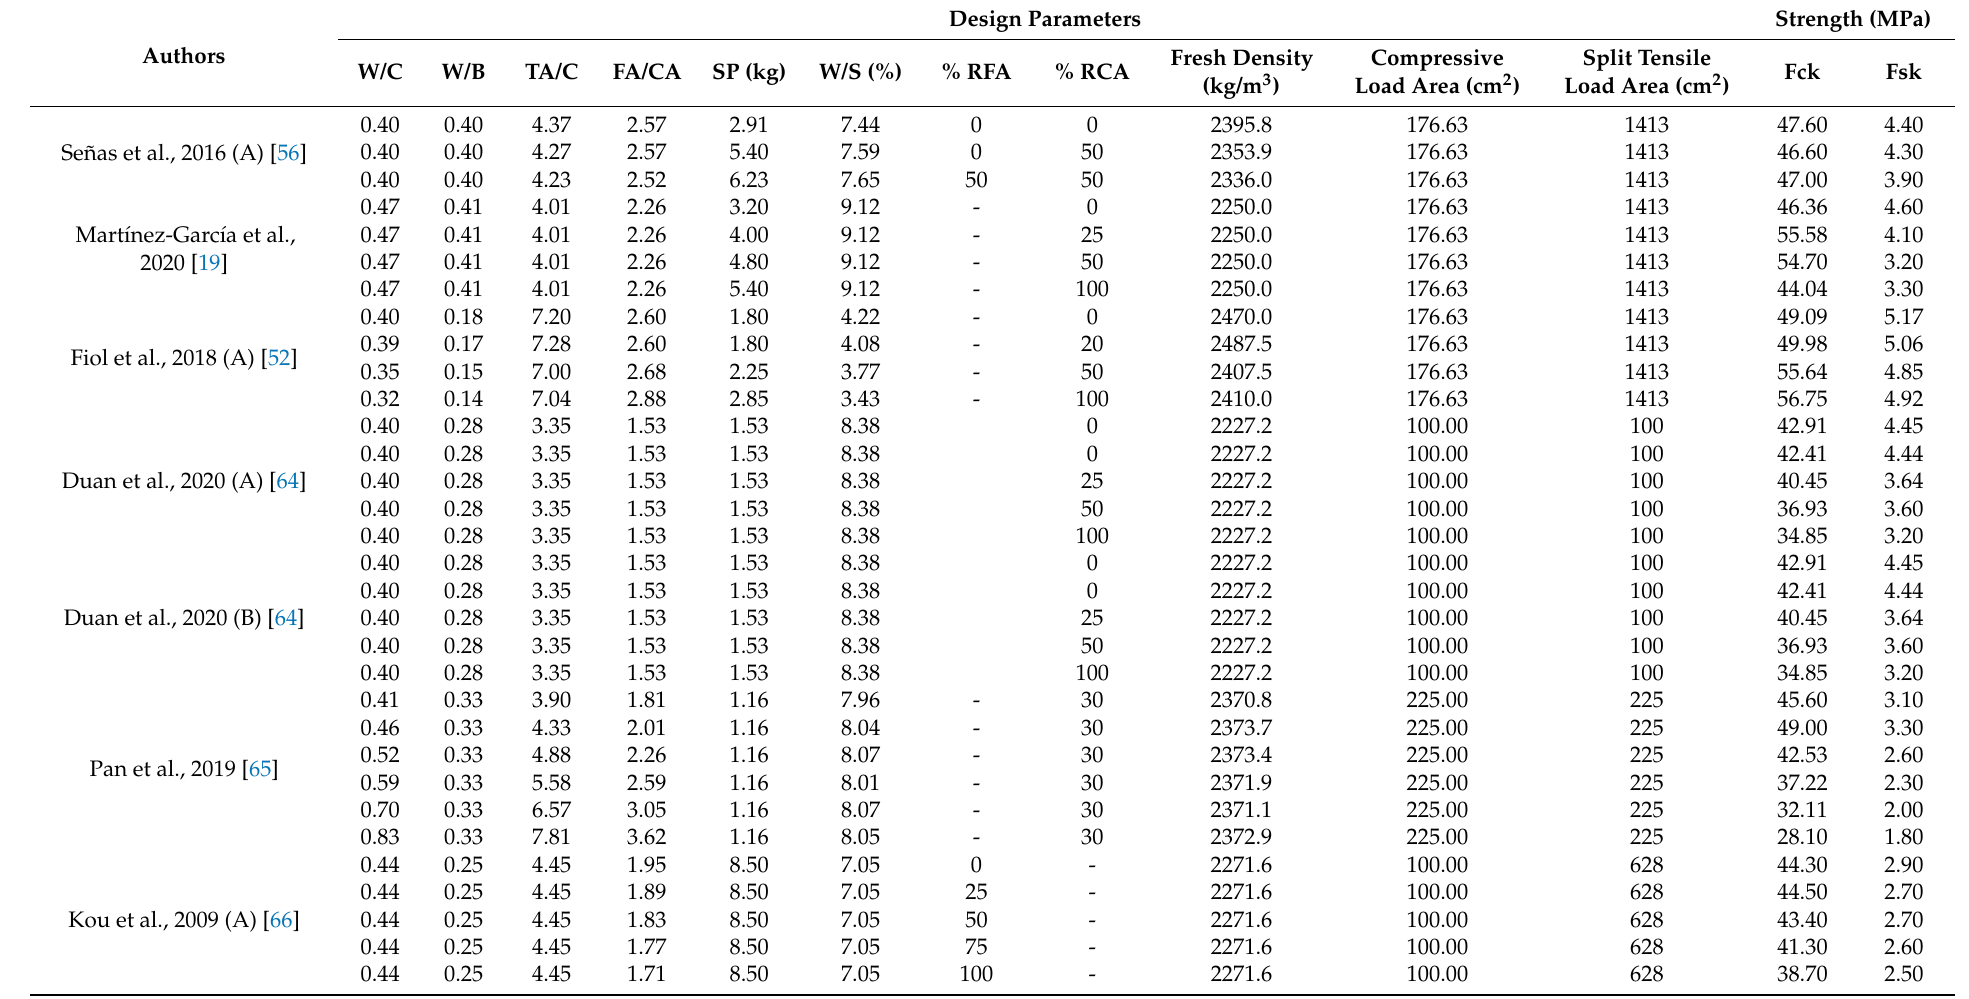
Table 4. Family IV (Compressive strength range–40 MPa to 50 MPa) design parameters according to